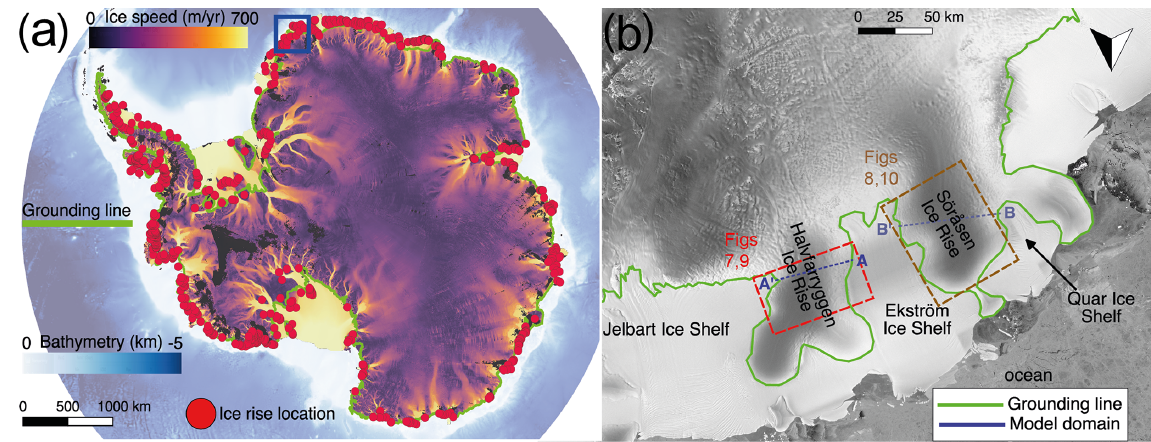
Figure 1. (a) Location map of ice rises along the margin of the Antarctic ice sheet (Matsuoka et al., 2015). The base map combines ice velocity of the ice sheet (Rignot et al., 2011) and the bathymetry of the adjacent ocean regions (Arndt et al., 2013). The blue rectangle shows zoomed-in area of (b) . (b) RADARSAT image (Jezek and 5 RAMP-Product-Team:, 2002) of the study area with locations mentioned in the main text. Dashed lines (A-A’, B-B’) show the extent of the cross section shown in Fig. 12. Please note that (b) is rotated by 180 ◦ with respect to (a)